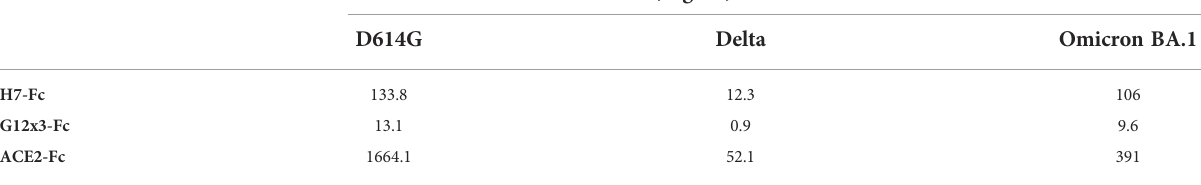
TABLE 2 Neutralizing activity (PRNT) of top antibody candidates in comparison with the ACE2-Fc